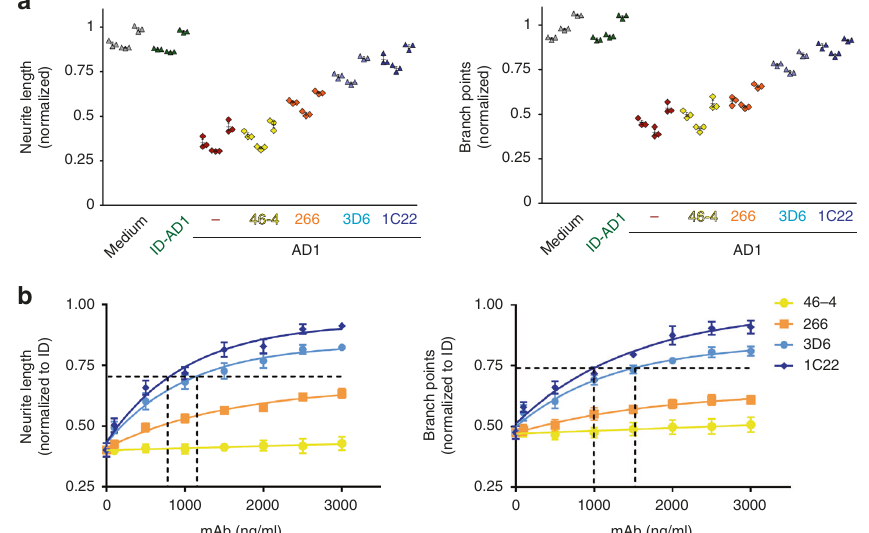
Fig. 7 MAb 1C22 more effectively protects against AD brain extract induced neuritotoxicity than either 3D6 or 266. Three independent experiments were conducted as in Fig. 6. a Graphs show the normalized change in NeuroTrack-de fi ned neurite length or branch points over the last 6 h of imaging of iNs treated with AD1 extract ± 3 μ g/ml mAbs 46 – 4, 266, 3D6, or 1C22. In each individual experiment, 1C22 almost completely protected against the neuritotoxicity of AD1 extract and always exerted a stronger effect than 3D6, and 3D6 always provided better protection than 266 (left panel, p = 0.9991, 1C22 vs 3D6; p < 0.0001, 1C22 vs 266, two-way ANOVA). Highly similar results were obtained for neurite branch points (right panel, p = 0.9464, 1C22 vs 3D6; p < 0.0001, 1C22 vs 266, two-way ANOVA). b To investigate the effect of mAb concentration, NeuroTrack-de fi ned neurite length (left panel) was averaged over the last 6 h of imaging for each treatment and values normalized to the immunodepleted AD1 treatment and neurite length plotted vs. antibody concentration. The ability of mAbs to protect neurite branch points (right panel) was determined in a similar fashion as described for neurite length. Values are the average ± SD of each condition analyzed in triplicate. When error bars are not visible they are smaller than the size of the symbol